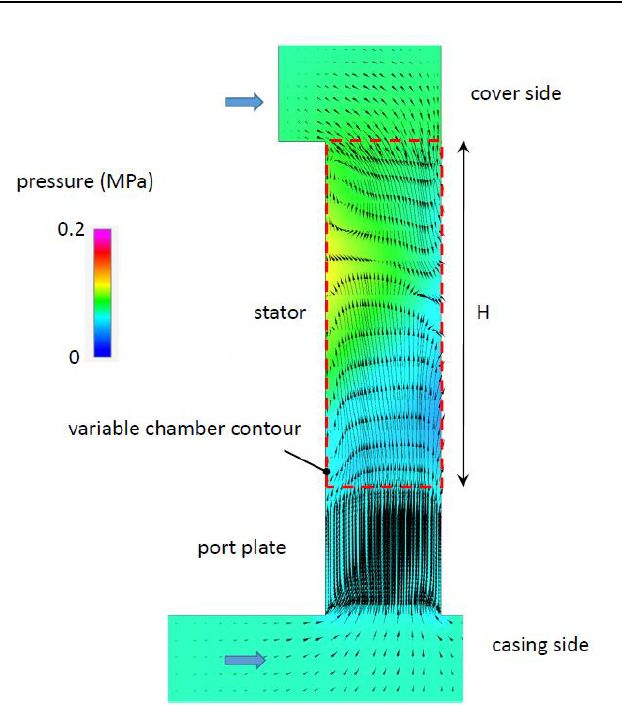
Figure 16. Pressure and velocity fields in a cross-section of a chamber at the end of the suction phase for the geometry M4 at 5000 rpm.